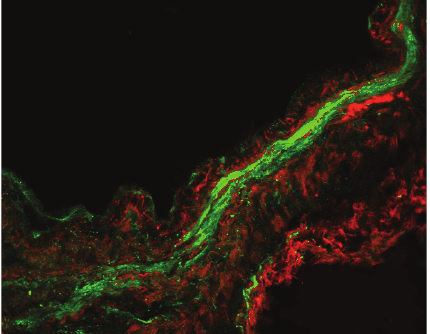
Figure 7: Overnight incubation of human airway with exogenously applied MBP. This representative image shows fluorescence of immunolabeled MBP (red) in human airway following incubation with MBP 10 − 5 M overnight. Compared to lesser duration of exposure (Figure 6), longer exposure, overnight, allowed MBP greater access to cells within the media of the airway wall. Notably this longer exposure allowed for significant immunolocalization to be detected within the smooth muscle layer (green) (confocal microscopy